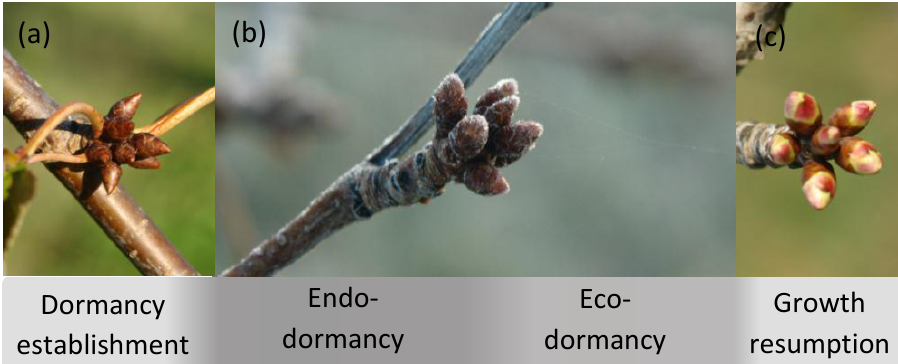
Figure 1. Phenological appearance of sweet cherry buds throughout winter dormancy: ( a ) dormancy establishment (BBCH 93, beginning of leaf fall), ( b ) endo- and eco- dormancy (BBCH 00 for dormant vegetative and BBCH 50 for dormant flower bud), and ( c ) growth resumption after eco-dormancy release (BBCH 01 for beginning of vegetative bud swelling and BBCH 51 for inflorescence buds swelling).